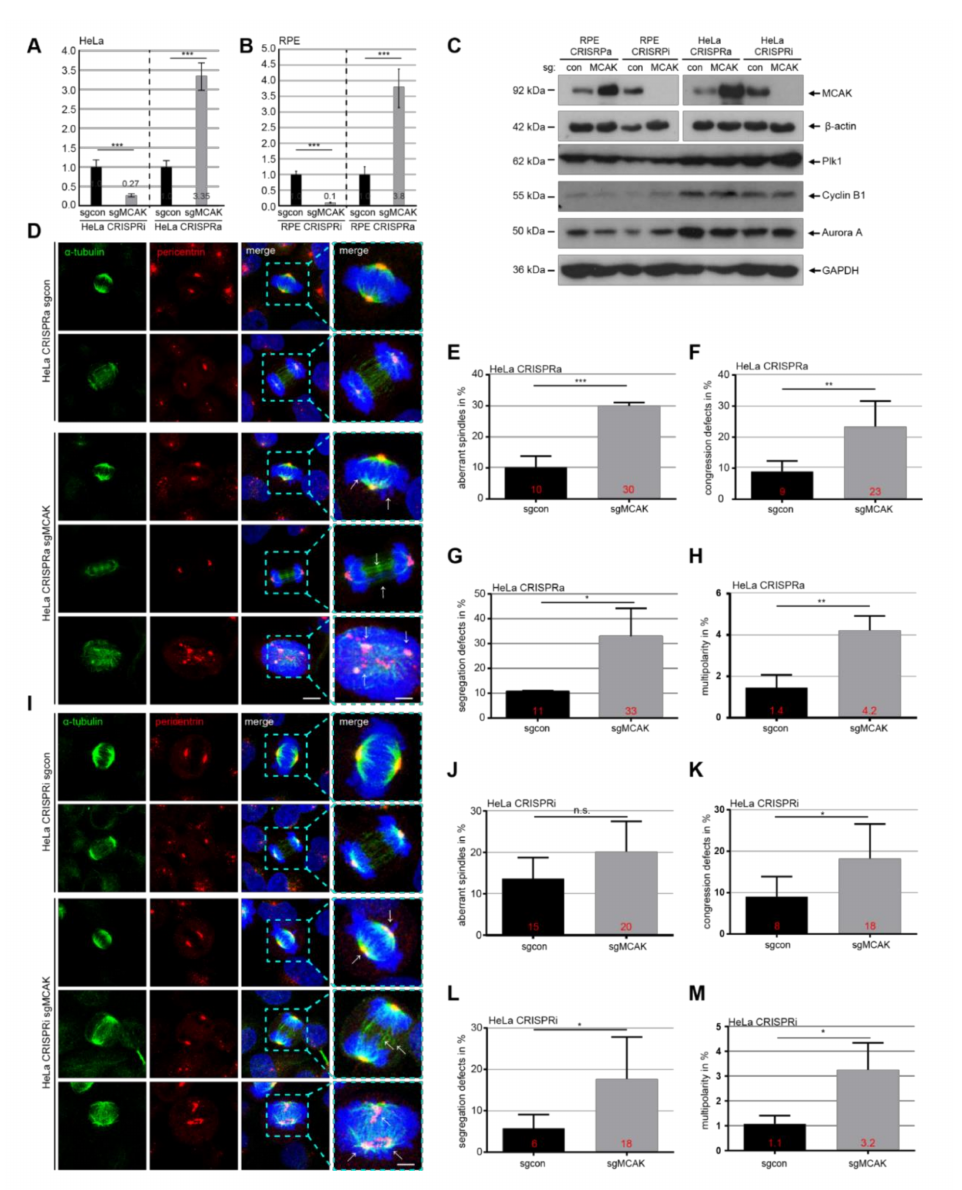
Figure 1. Mitotic defects in HeLa CRISPRi/a cells. ( A , B ) The gene level of KIF2C (MCAK) was analyzed in HeLa/RPE CRISPRi/a cells (i for inhibition/suppression, a for activation/overexpression, sgMCAK, targeting MCAK), compared to their corresponding control cells (sgcon). Glyceraldehyde-3-phosphate dehydrogenase (GAPDH) served as the endogenous control. The data are based on three independent experiments and presented as RQ with minimum and maximum range and statistically analyzed. RQ: relative quantification of the gene expression. ( C ) Control Western blot analysis. The membrane was stained with indicated antibodies and GAPDH served as the loading control. ( D ) HeLa CRISPRa cells were stained with antibodies against α -tubulin (green), pericentrin (red) and DAPI (4,6-diamidino-2-phenylindole) for confocal microscopy. Representatives are shown. White arrows indicate misaligned chromosomes, defective segregation or multipolar spindles. Scale: 7.5 µ m, inset scale: 2.5 µ m. ( E – H ) Evaluation of aberrant spindles ( E ), misaligned chromosomes ( F ), failed segregation ( G ), and multipolar spindles ( H ) in HeLa CRISPRa cells. ( I ) Representatives of HeLa CRISPRi cells are shown. White arrows indicate misaligned chromosomes, defective segregation or multipolar spindles. Scale: 7.5 µ m, inset scale: 2.5 µ m. ( J – M ) Evaluation of aberrant spindles ( J ), misaligned chromosomes ( K ), failed segregation ( L ), and multipolar spindles ( M ) in HeLa CRISPRi cells. Results presented in ( E–H ) and ( J–M ) are from three independent experiments ( n = 3, 50 mitotic cells for each condition in each experiment) and presented as mean ± SEM. Student’s t -test was used. * p < 0.05, ** p < 0.01, *** p < 0.001. Abbreviation: n.s.: not